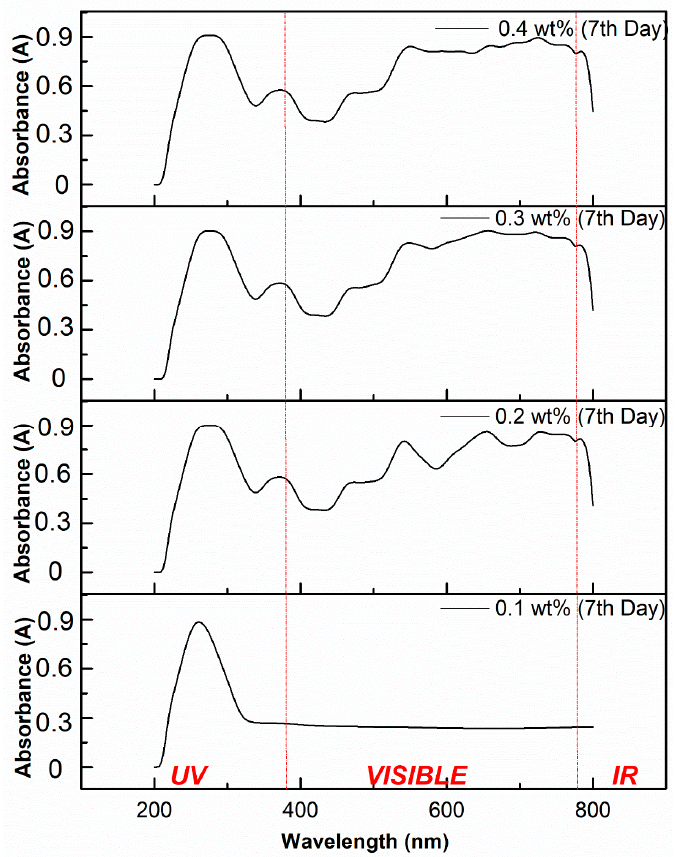
Figure 9. Absorption spectra of ionanofluids with di ff erent weight concentration on the seventh day.